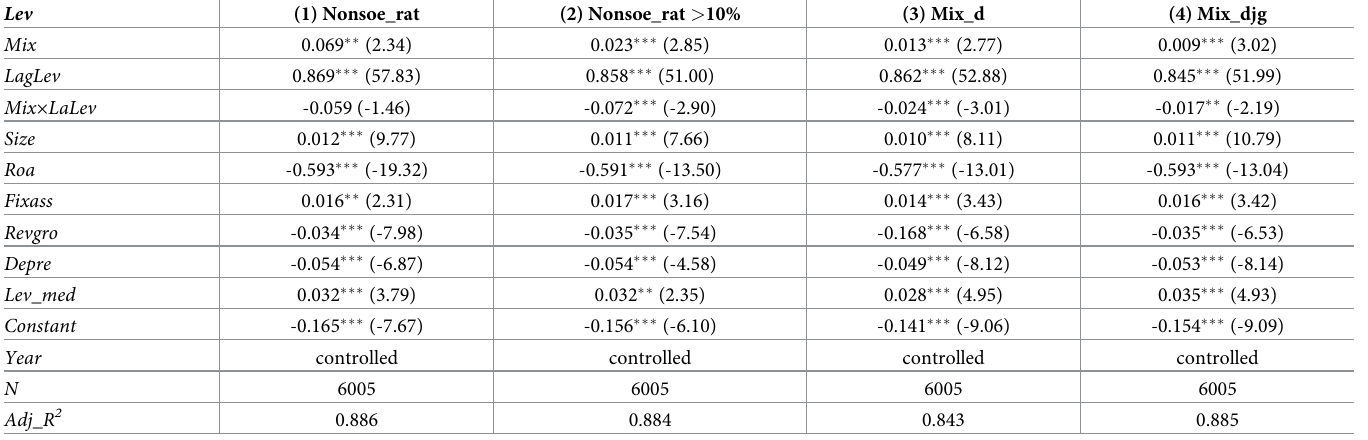
Table 3. The non-state-owned shareholder ‘s governance and the speed of the capital structure adjustment.